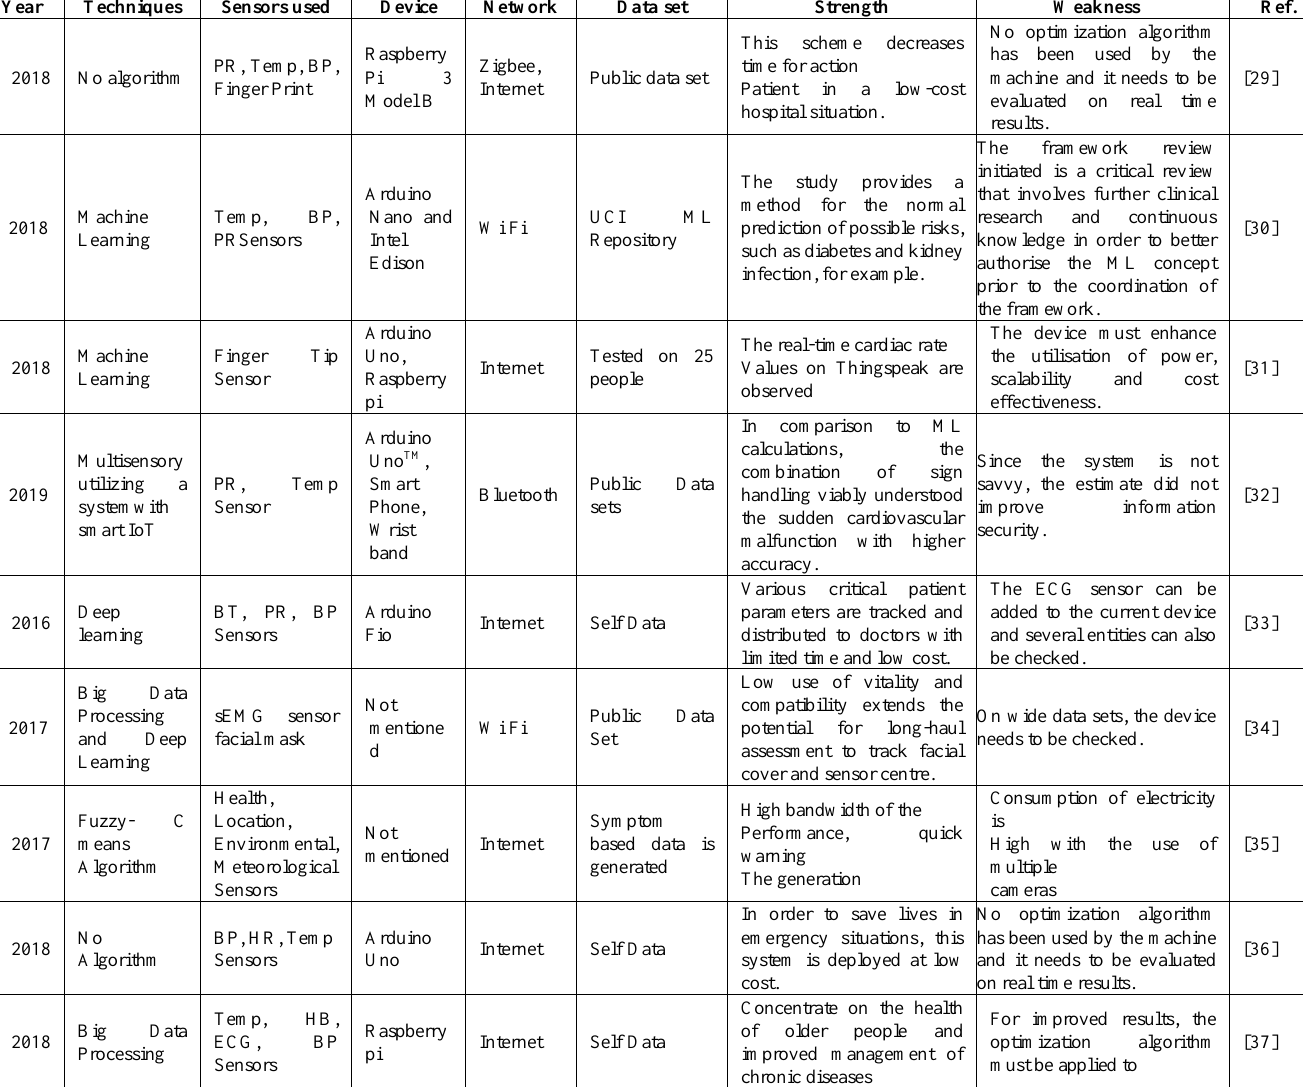
Table 2 – Comparison table on techniques, devices, senosrs, network and data set used in